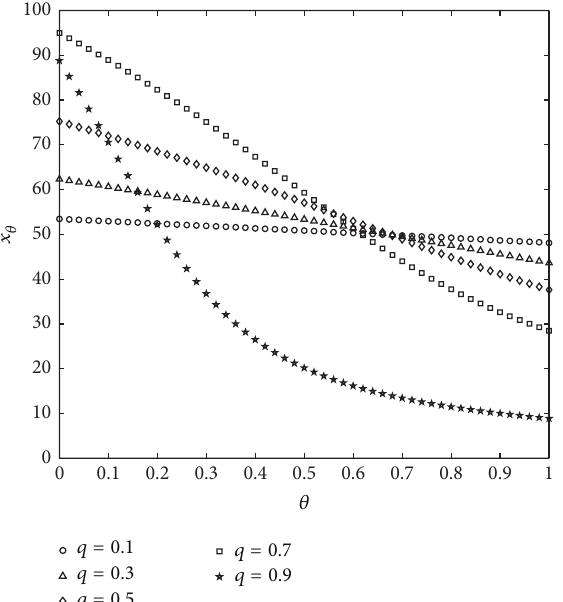
Figure 2: The effects of instant killing rate 𝑞 and pesticide application time 𝜃 on the values of 𝑥 ∗ 𝜃 . The parameter values are as follows: = 0.5 , 𝐾 = 50 , 𝛿 = 0.3 , 𝑞 = 0.1 , 𝛾 = 1 , 𝛼 = 0.007 , and 𝑟 = 2.8 𝑇 = 10 , 𝑇 ℎ